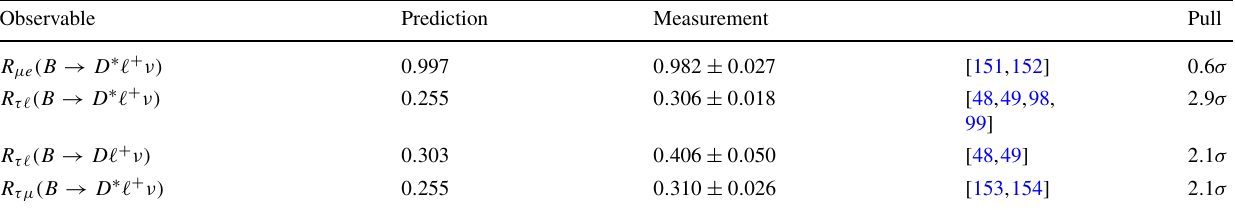
Table 6 Charged-current LFU-testing observables R D ( ∗